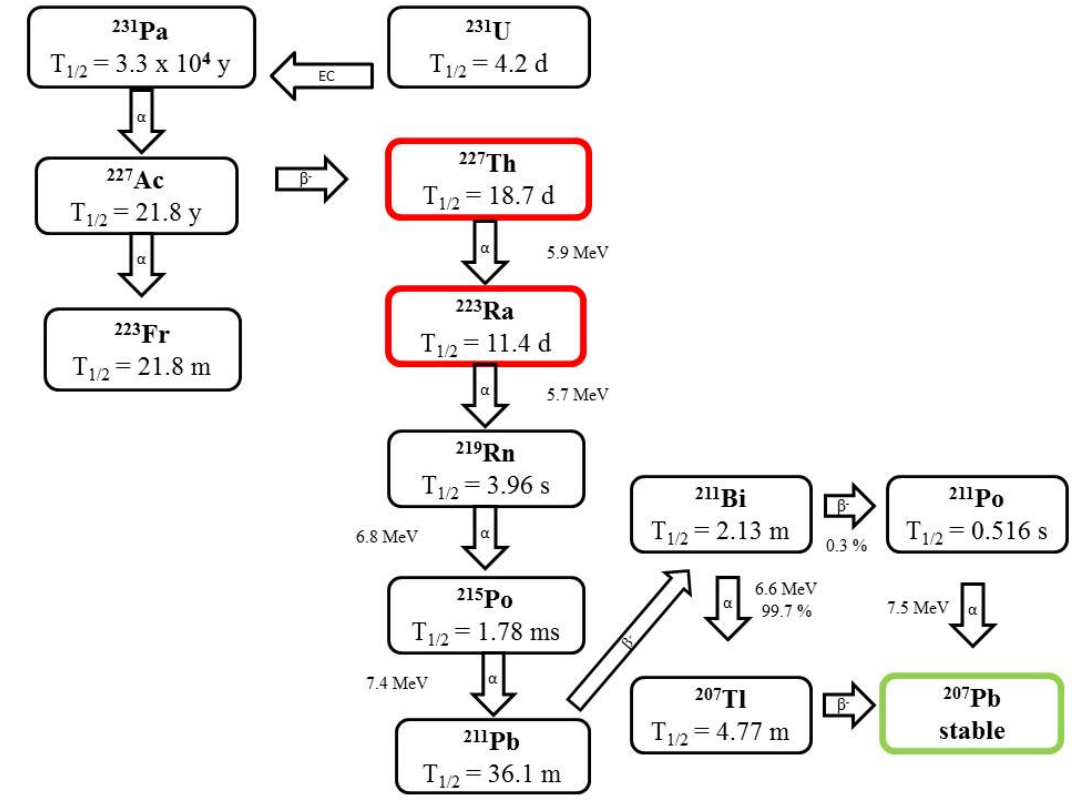
Figure 4. Decay scheme of 223 Ra.